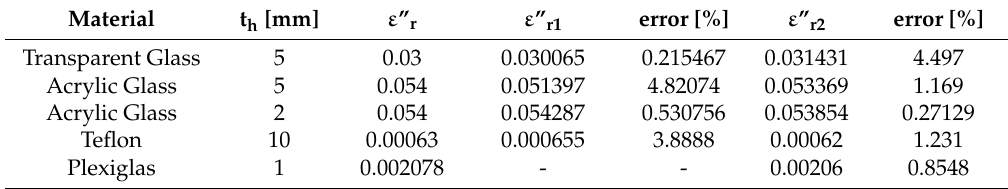
Table 4. Imaginary part of the complex permittivity for di ff erent materials under